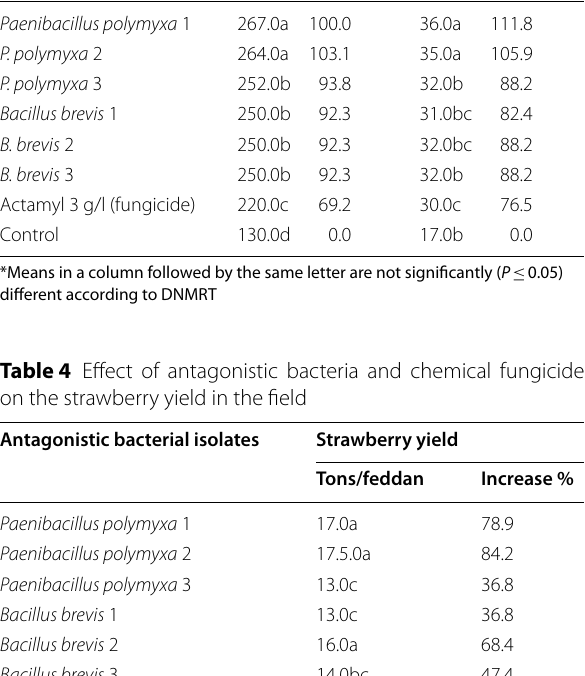
Fig. 3 Effect of antagonistic bacteria on black root rot disease of strawberry plants, relatively unhealthy and less plant densities are seen in the untreated check